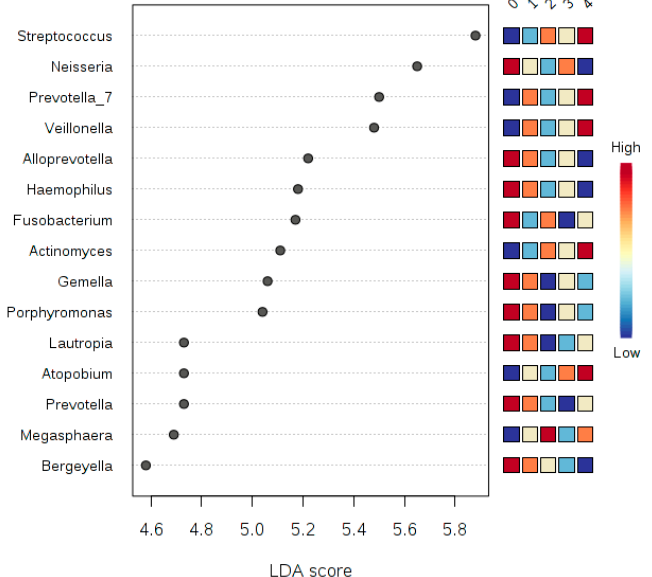
Figure 8. A plot of the LDA scores of the top 15 genera showing statistically significant differences between binned years of smoking. LDA scores on the x -axis, and genera on the y -axis. The color-coding in the squares of the right side of the plot refers to the cumulative abundance of each genus in each binned group, where red means high cumulative abundance and blue means low cumulative abundance.